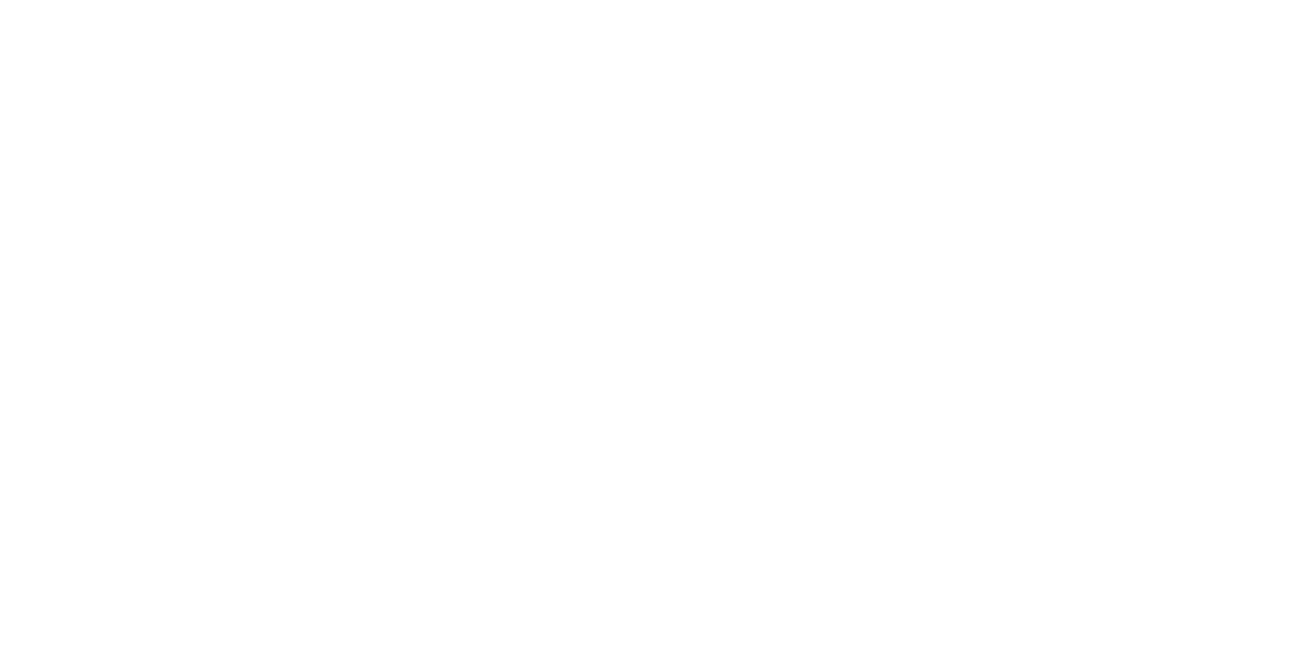
FigureA| Alternativemodelwithstandardisedregressionweightsandsquaredmultiplecorrelations.( χ 2/df (cid:1) 1.657, p (cid:1) 0.000;RMSEA (cid:1) 0.055,LO90 (cid:1) 0.043,HI 90 (cid:1) 0.066; CFI (cid:1) 0.963; TLI (cid:1) 0.956; GFI (cid:1) 0.893; AGFI (cid:1)